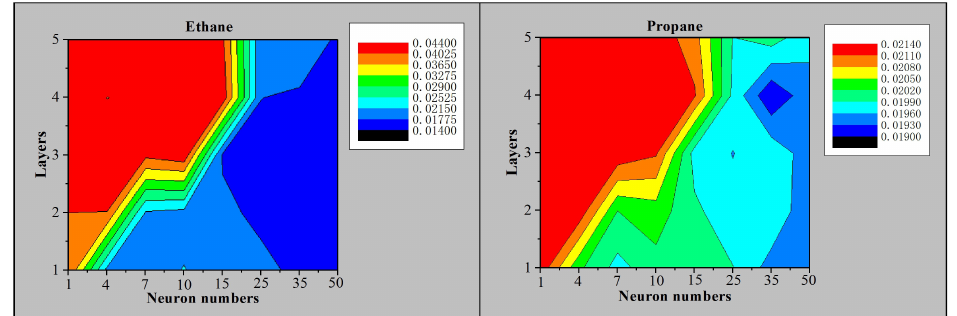
Figure 6. Average error rates of ANN with different layers/neuron numbers.